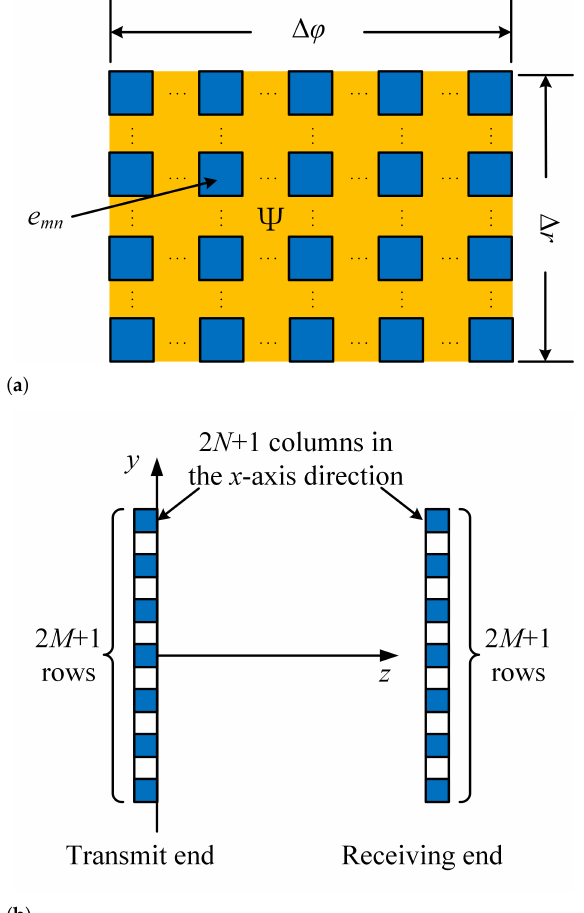
Figure 4. Array configuration in the WPT scenario. ( a ) The receiving array structure for the configu- ration in [29–32], ( b ) schematic diagram of the transceiver array system applied in the WPT